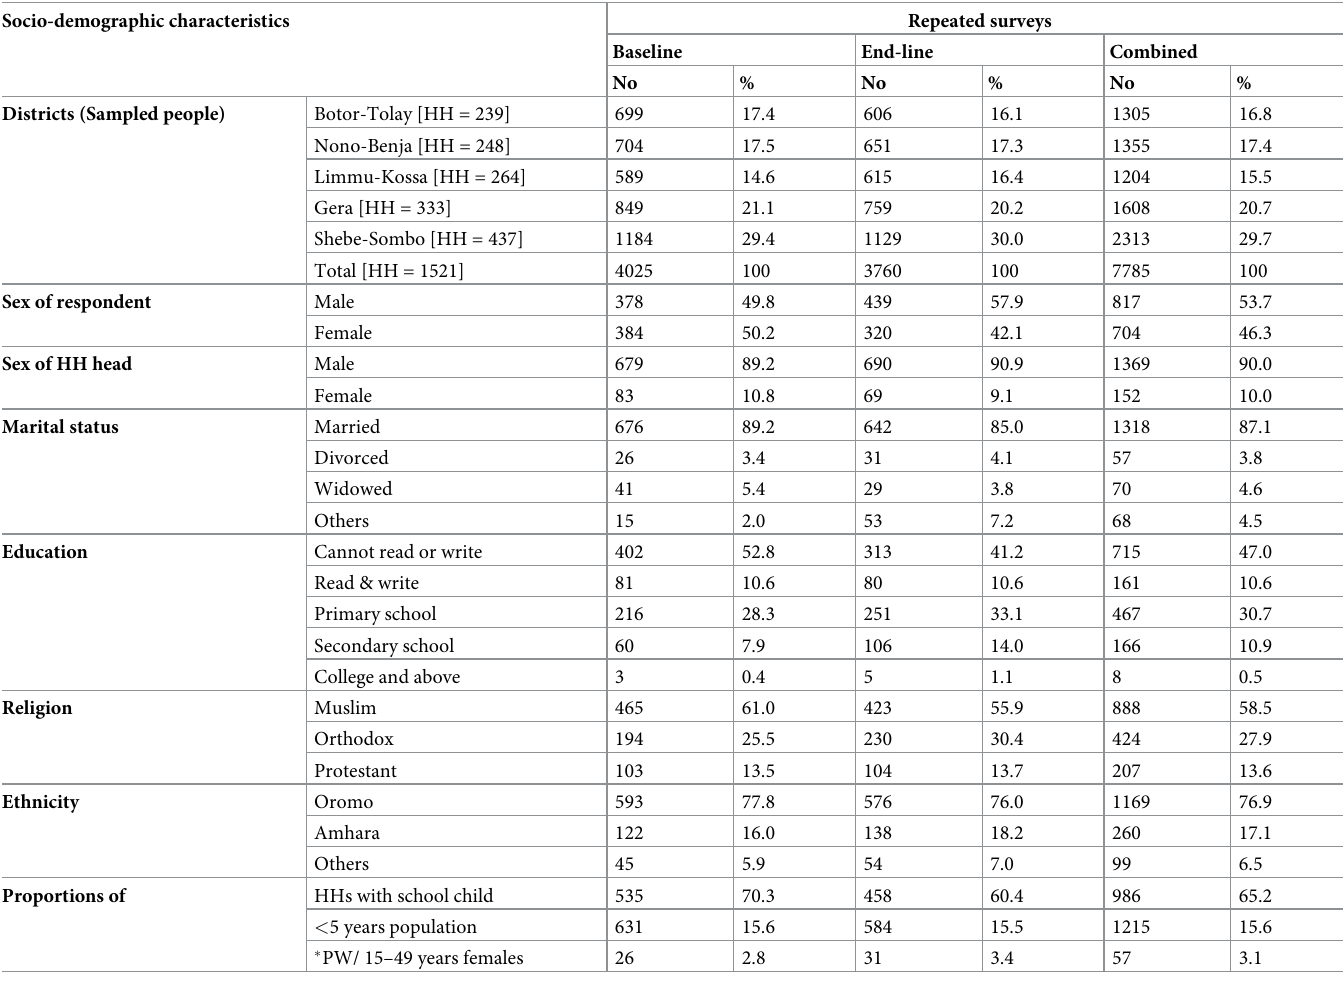
Table 1. Socio-demographic characteristics of respondents, school-based malaria SBCC target districts, Jimma Zone, Ethiopia, 2017–2019 (baseline, n = 762; end line, n = 759). Socio-demographic characteristics